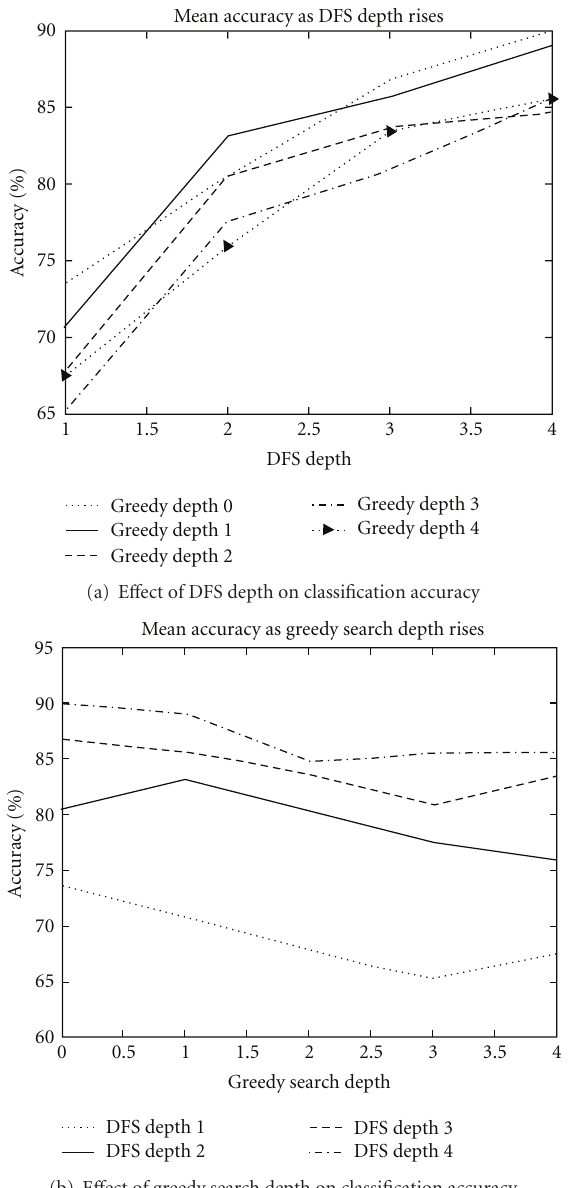
Figure 7: E ff ect of search depth on classification accuracy, (a) and (b).